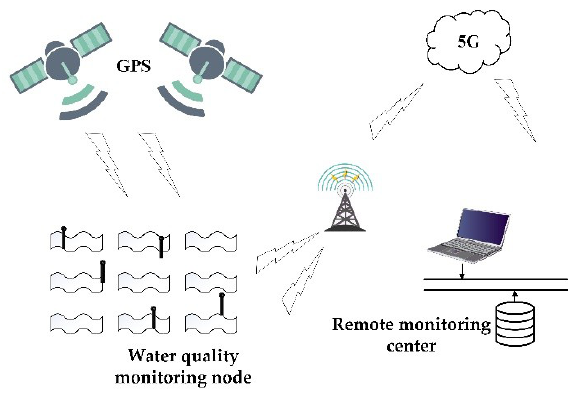
Figure 6. Schematic diagram of water quality parameter monitoring and an early warning system.